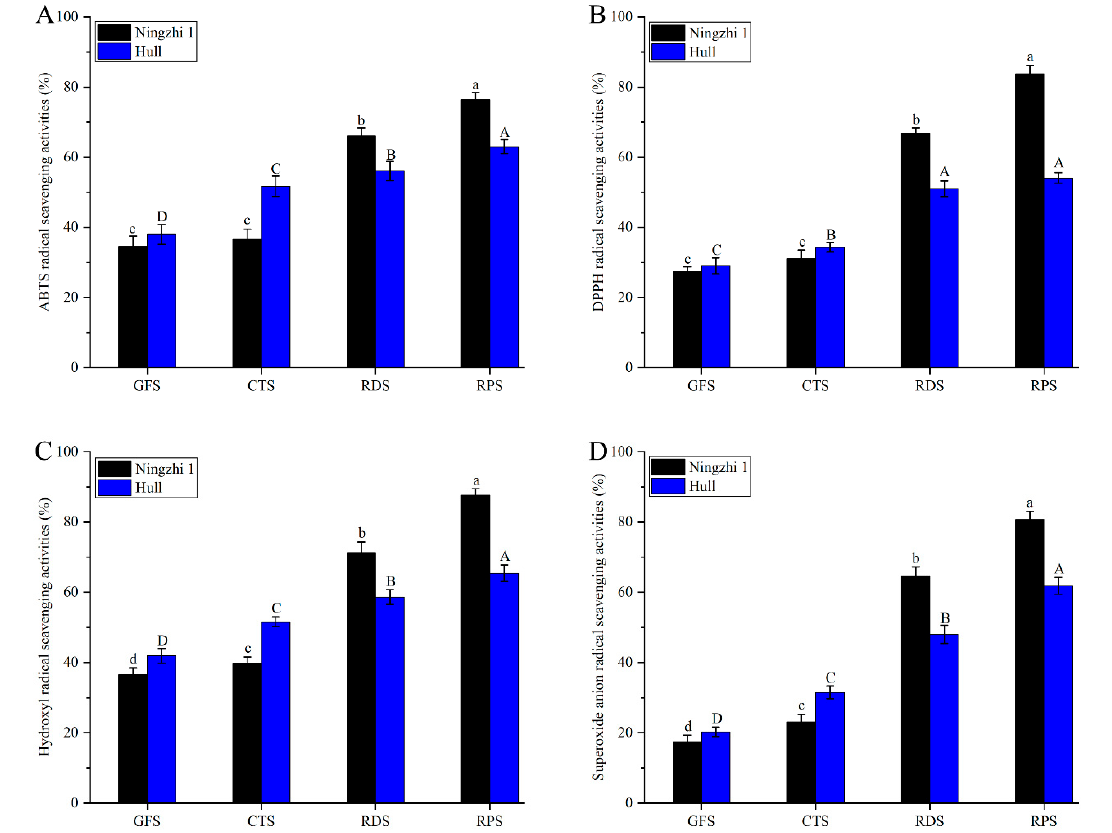
Figure 3. Antioxidant activity of anthocyanidin in blackberry fruit at different growth stages. ( A ) ABTS radical-scavenging activities. ( B ) DPPH radical-scavenging activities. ( C ) Hydroxyl radical-scavenging activities. ( D ) Superoxide anion-scavenging activities. Lowercase letters and uppercase letters mean the significance ( p < 0.05) of antioxidant activity of non-anthocyanidin flavonoids in Ningzhi 1 and Hull blackberry at different growth stages.